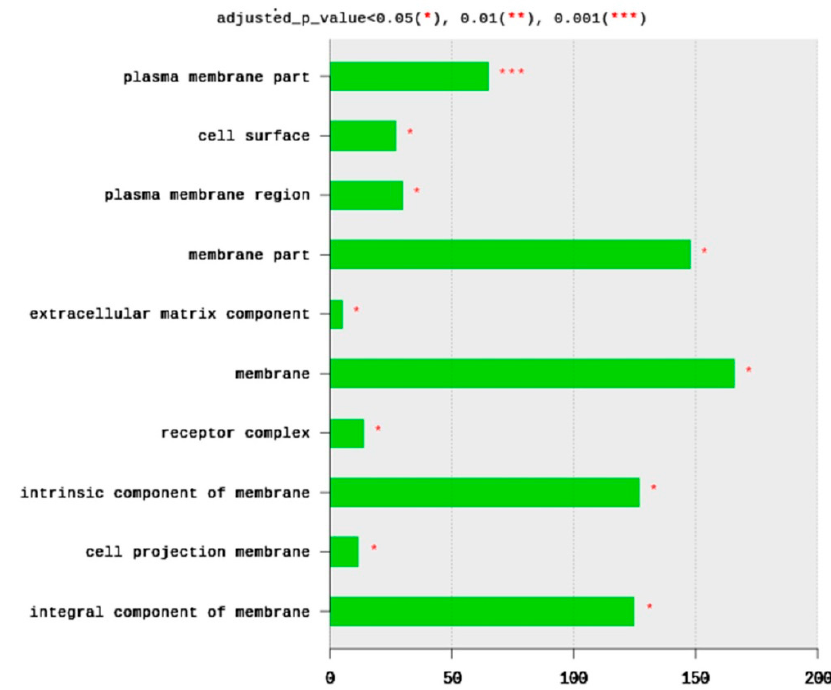
Figure 3. Distribution of GO top 10 enriched cellular components (CC) terms, adjusted p < 0.05. The Y axis represents the enriched BP terms, X axis represents the intersection size (the number of DEGs for a CC term).